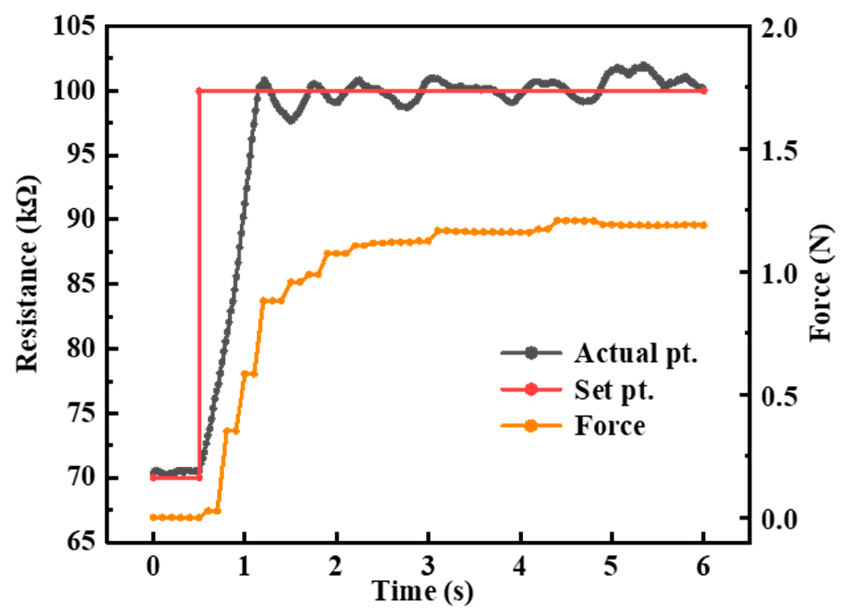
Figure 14. Demonstration of the closed-loop control of SHEPA, in which the set resistance was 100 k Ω